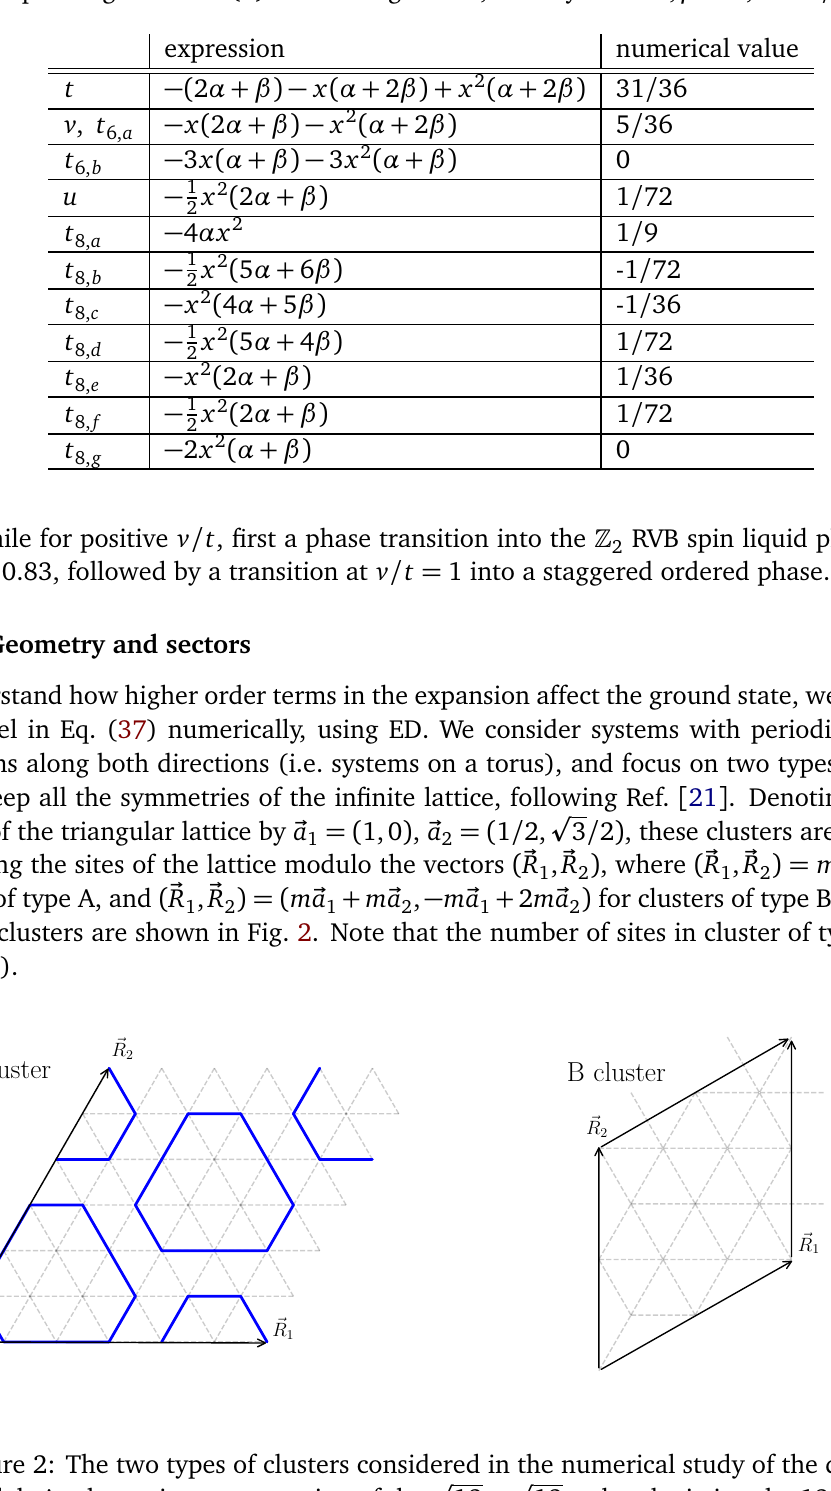
(cid:112) (cid:112) 12 × 12 order, depicting the 12-site